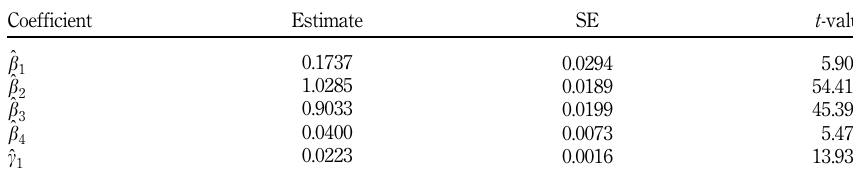
Table IV. Tests for threshold effects of past two- quarter